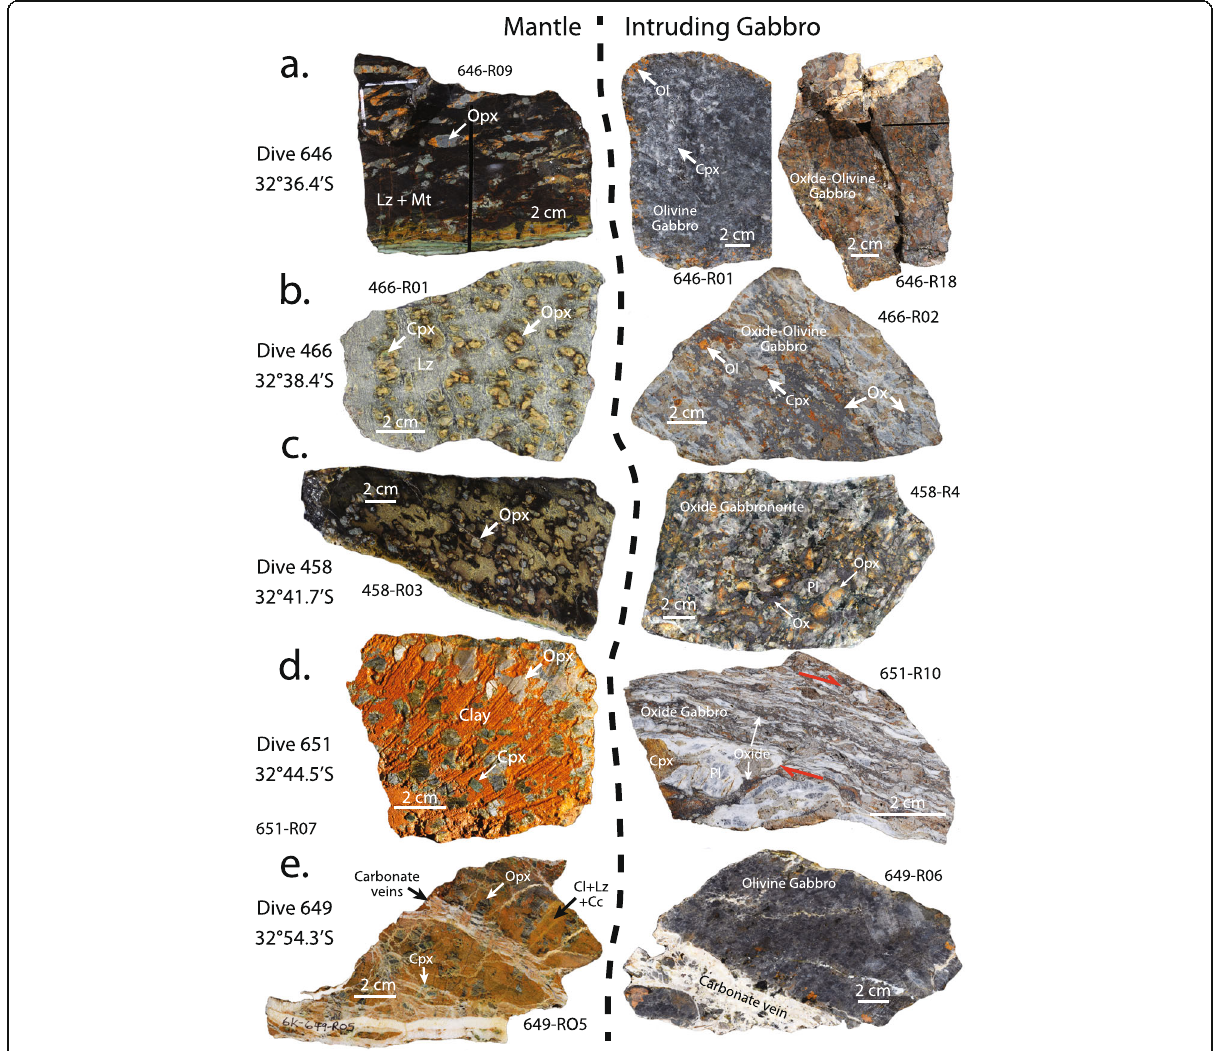
Fig. 49 Samples from directly above and below the gabbro-peridotite contact. a Weakly foliated porphyroclastic lherzolite (C-P 1) and undeformed equigranular olivine and oxide gabbros. b Weakly foliated porphyroclastic lherzolite (C-P 0.5) and weakly deformed (C-P 1) oxide- olivine gabbro with a 4.5 cm-wide oxide-rich band. c Weakly foliated porphyroclastic lherzolite and an undeformed equigranular oxide-olivine gabbro. d Weathered, protogranular lherzolite (C-P 0.25), and lightly deformed (C-P 0.75), pegmatoidal oxide-olivine gabbro with a 3.5 cm-wide protomylonitic oxide-olivine gabbro band. e Weathered weakly foliated (C-P 1.5) lherzolite with carbonate veins and an undeformed (C-P 0), equigranular olivine